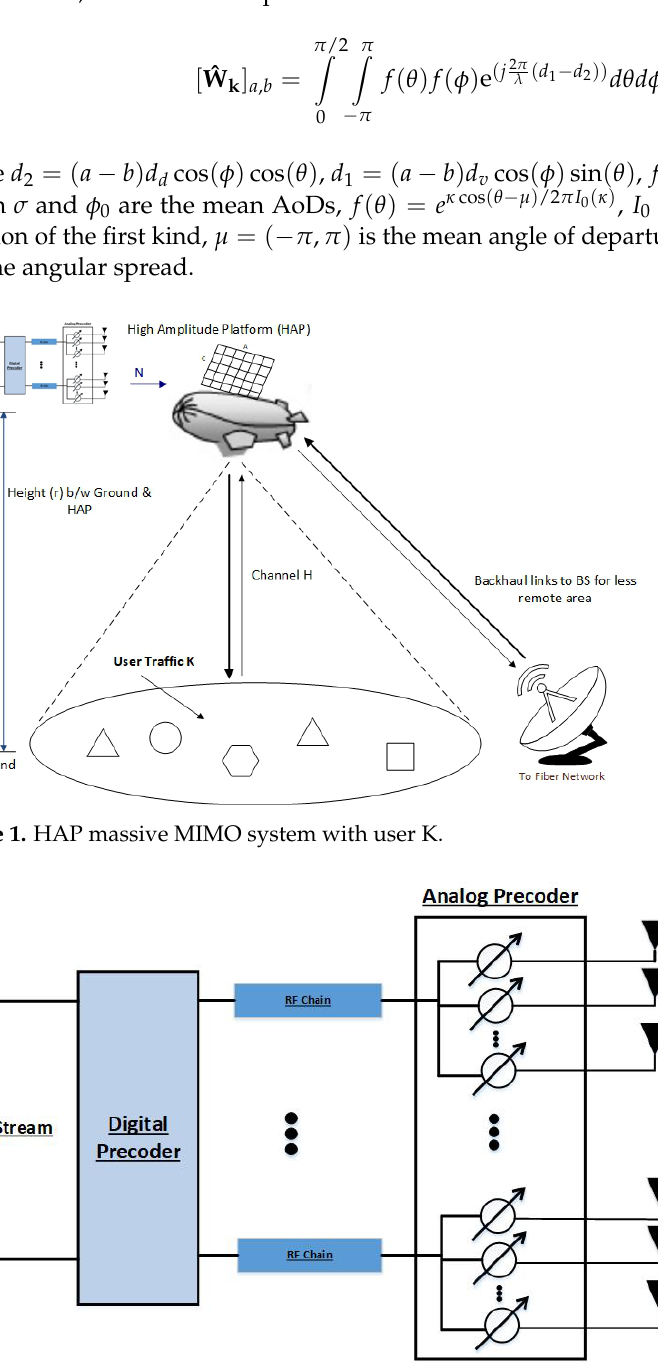
Figure 2. Sub-connected hybrid precoding